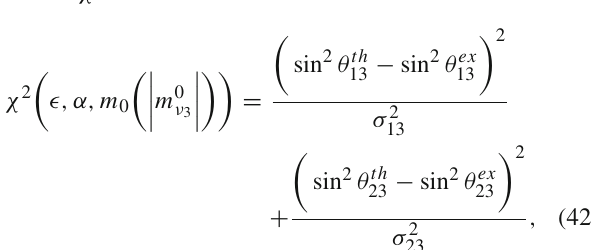
The χ 2 function is built